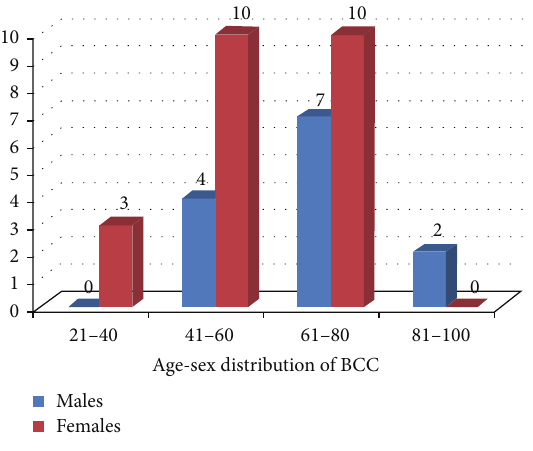
Figure 8: Age-sex distribution of